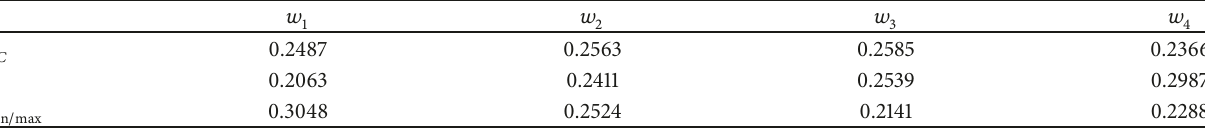
Table 13: Entropies and weights of the criteria.